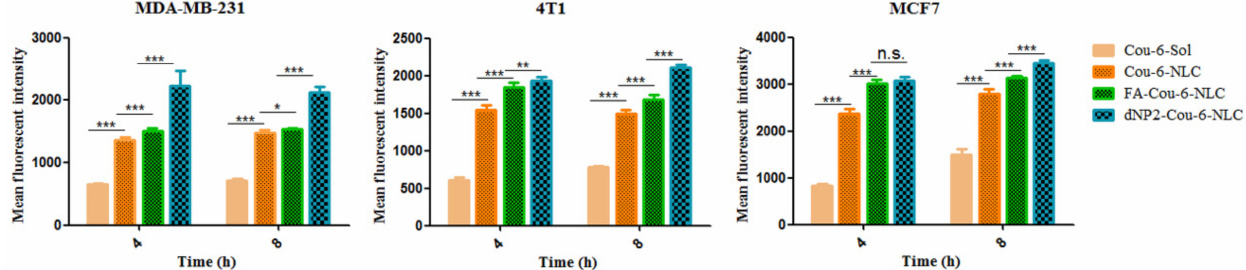
Figure 3. The cellular uptake in MDA-MB-231, 4T1, and MCF-7 cells after treatment with Cou-6-Sol, Cou-6 labeled NLC, and modified Cou-6 labeled NLC at different incubation time intervals (4 h, 8 h). * p < 0.05; ** p < 0.01; *** p < 0.001; n.s., not significant. Results are expressed as mean ± SD, n =